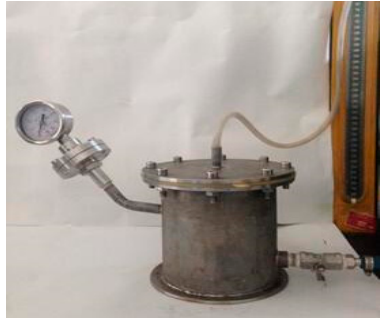
Figure 2. The self ‐ designed and self ‐ made detection device for air tightness of sealing coating. Figure 2. The self-designed and self-made detection device for air tightness of sealing coating.